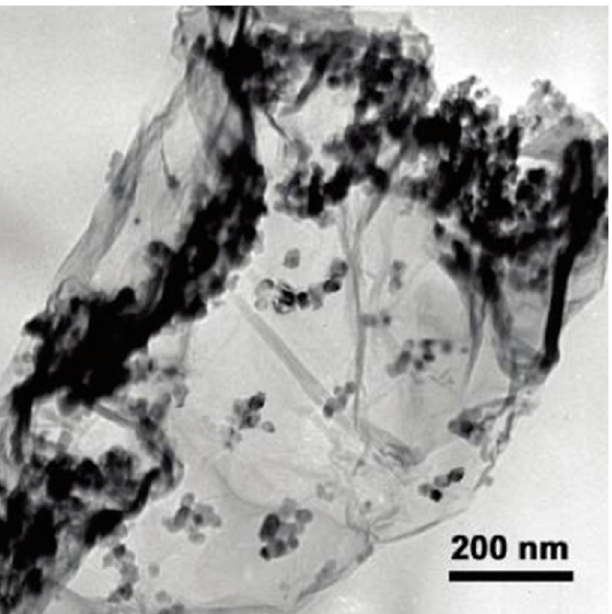
Figure 5. Composite of TiO 2 P25 nanoparticles decorated on reduced graphene oxide following a hydrothermal process which showed an elevated photodecomposition performance against methylene blue both under ultraviolent and visible light irradiation. Reprinted with permission from Ref. [106]. Copyrights Elsevier, 2009.